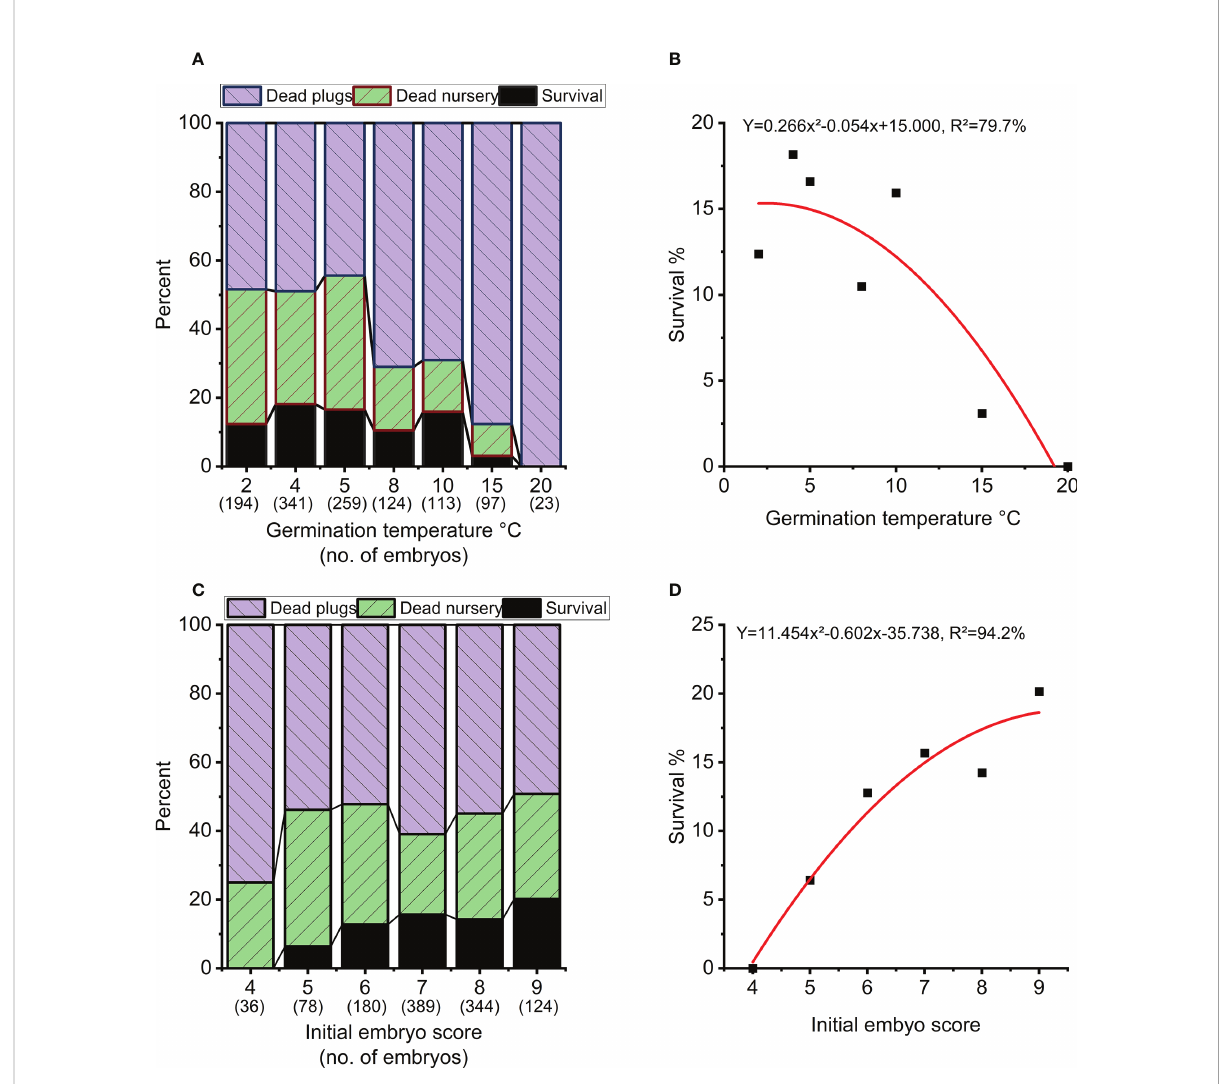
FIGURE 5 Survival in percentage of starting numbers of embryos at the end of nursery growth (black), mortality during the 8 weeks of plant growth in plugs (blue) and 3 years of plant growth in the nursery (green). (A, B) Overall survival as a function of temperature during germination. (C, D) Overall survival as a function of initial embryo